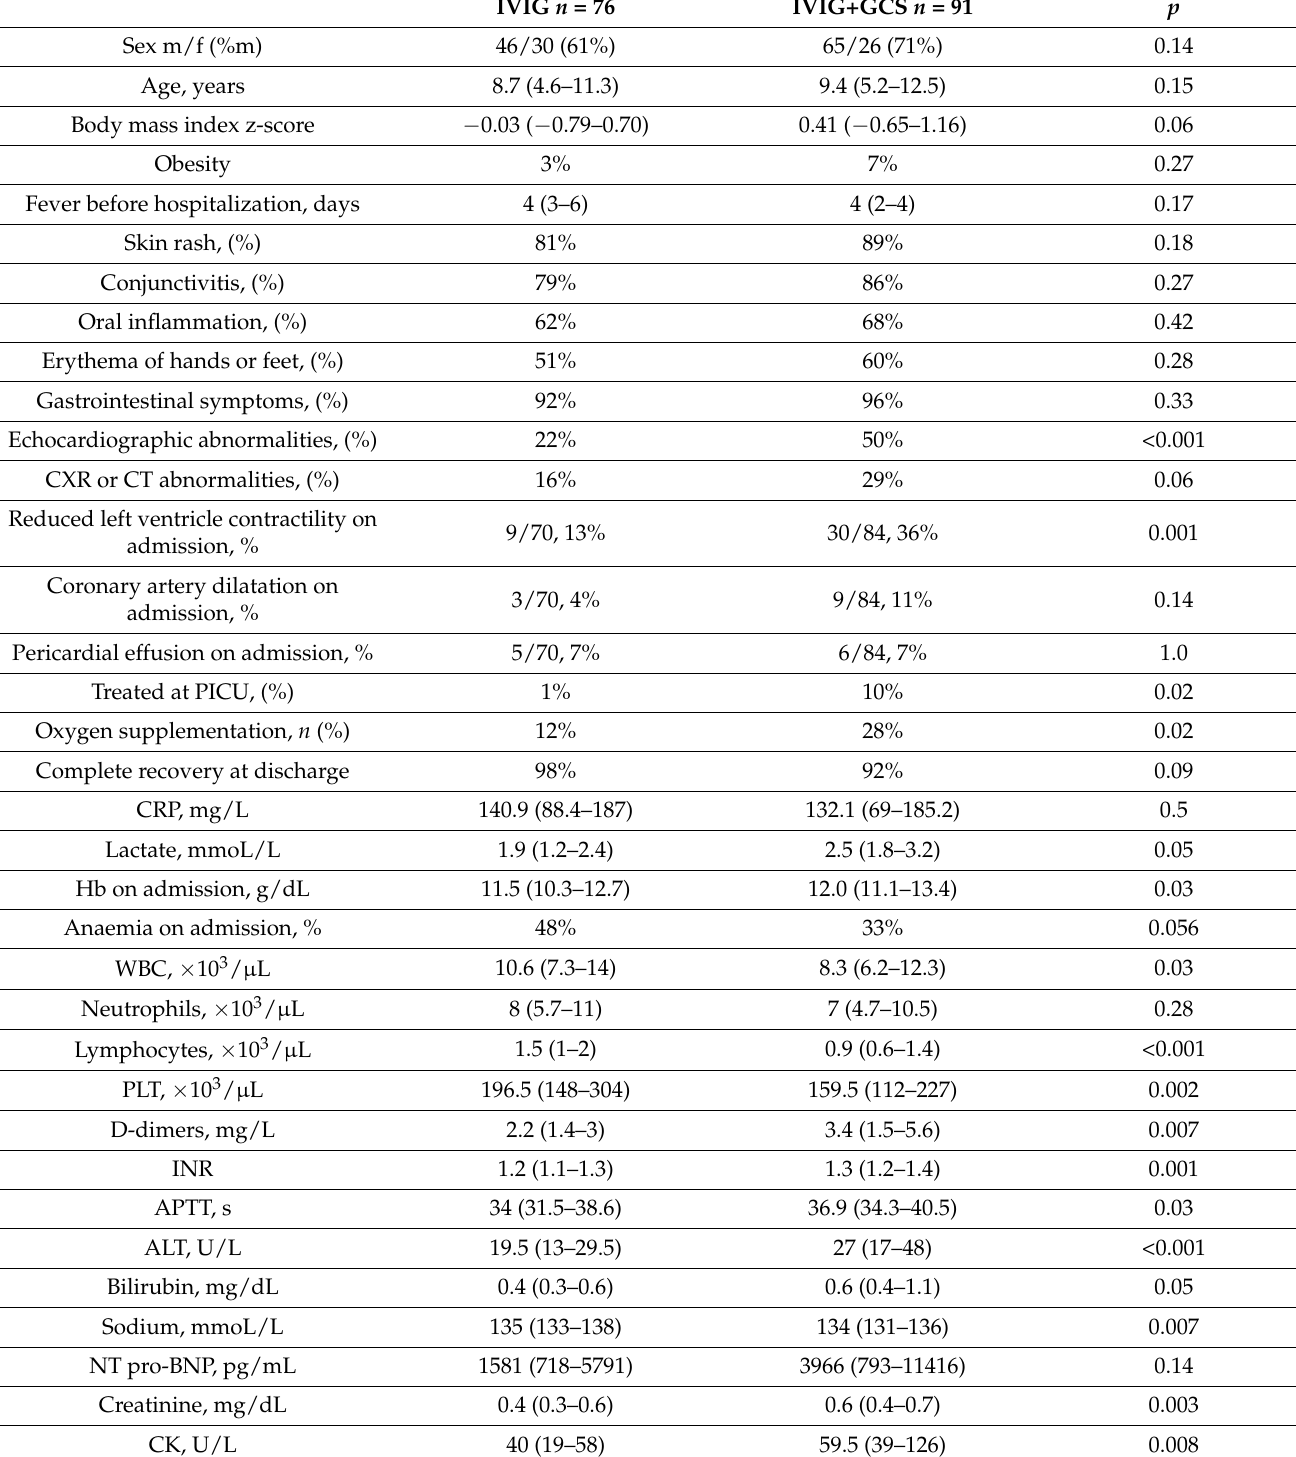
Table 1. Demographic characteristics of the study group and comparison between the group treated with IVIG and the group treated with